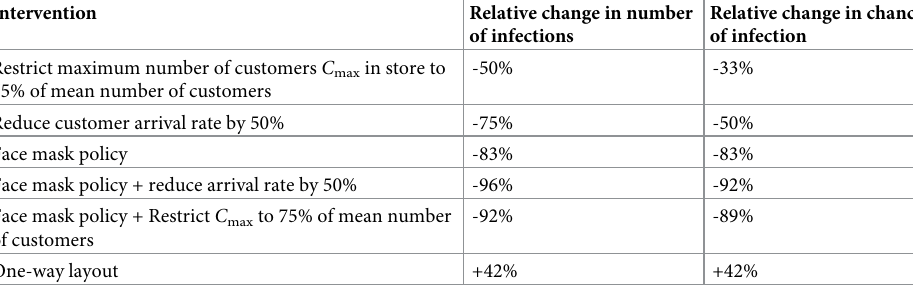
Table 3. Comparison of interventions and combinations of interventions. We compare possible interventions and combinations of interventions by their effect on the number of infections and chance of infection based on our agent- based model. We can achieve the largest amount of reduction by combining the face mask policy with reducing arrival rate or the maximum number of customers. Intervention Relative change in number Relative change in chance of infections of infection Restrict maximum number of customers C max in store to -50% -33% 75% of mean number of customers Reduce customer arrival rate by 50% -75% -50% Face mask policy -83% -83% Face mask policy + reduce arrival rate by 50% -96% -92% Face mask policy + Restrict C max to 75% of mean number -92% -89% of customers One-way layout +42%